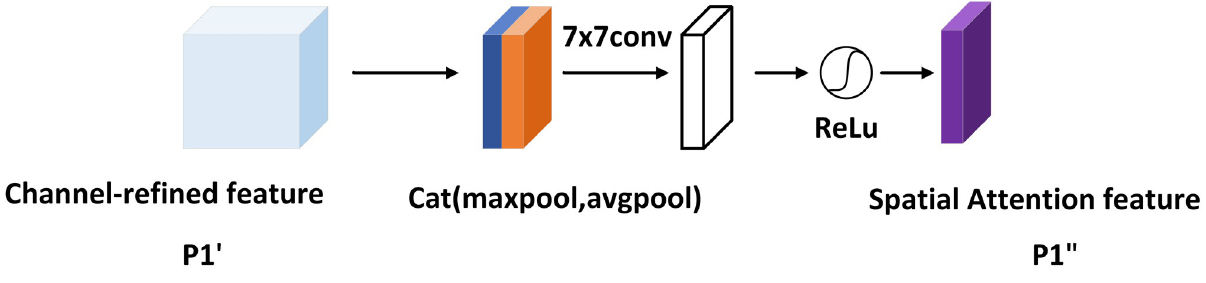
Fig 6. Spatial attention module